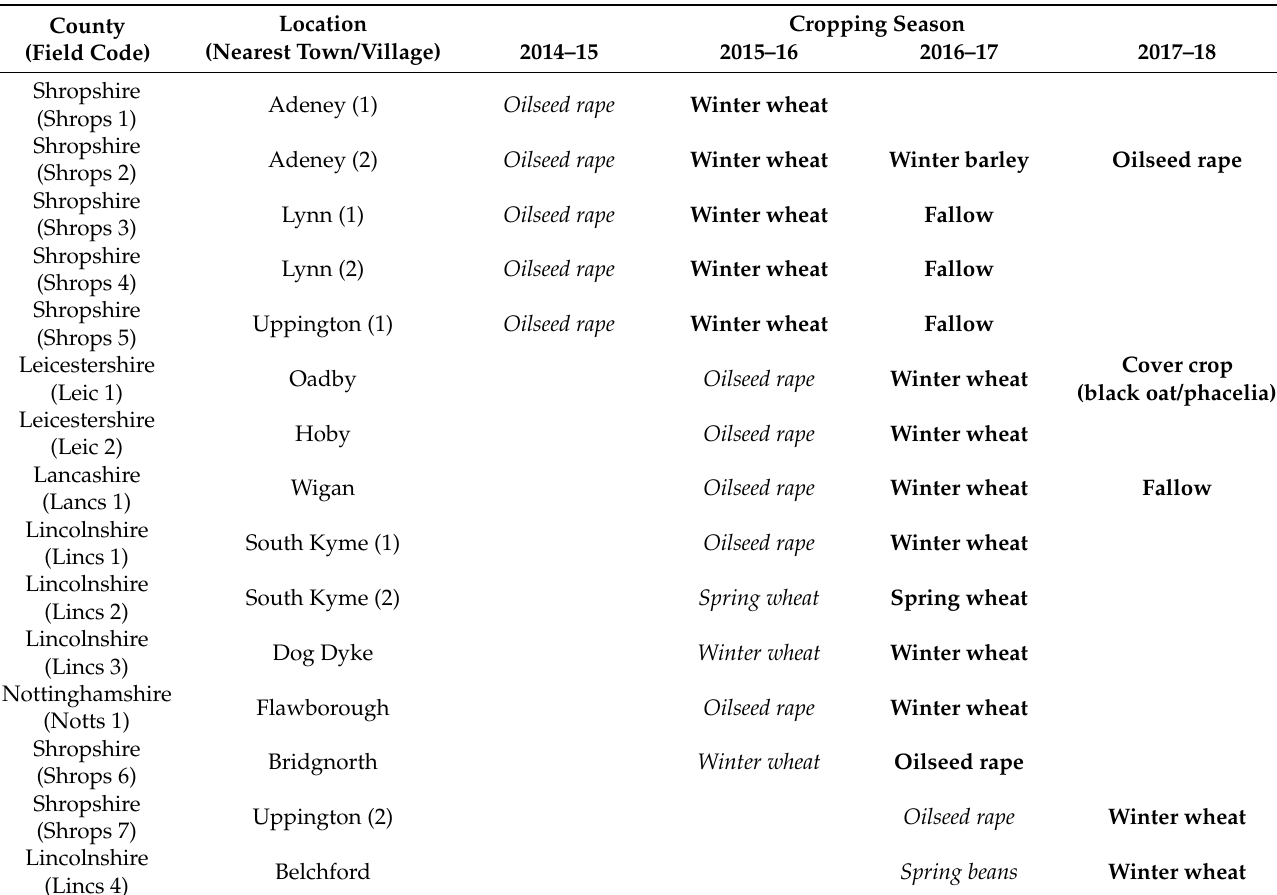
Table 1. Location, field codes and crop rotations of experimental field sites in each year of the study. Crops in bold were used in experiments; crops in italics were grown prior to the commencement of experimental